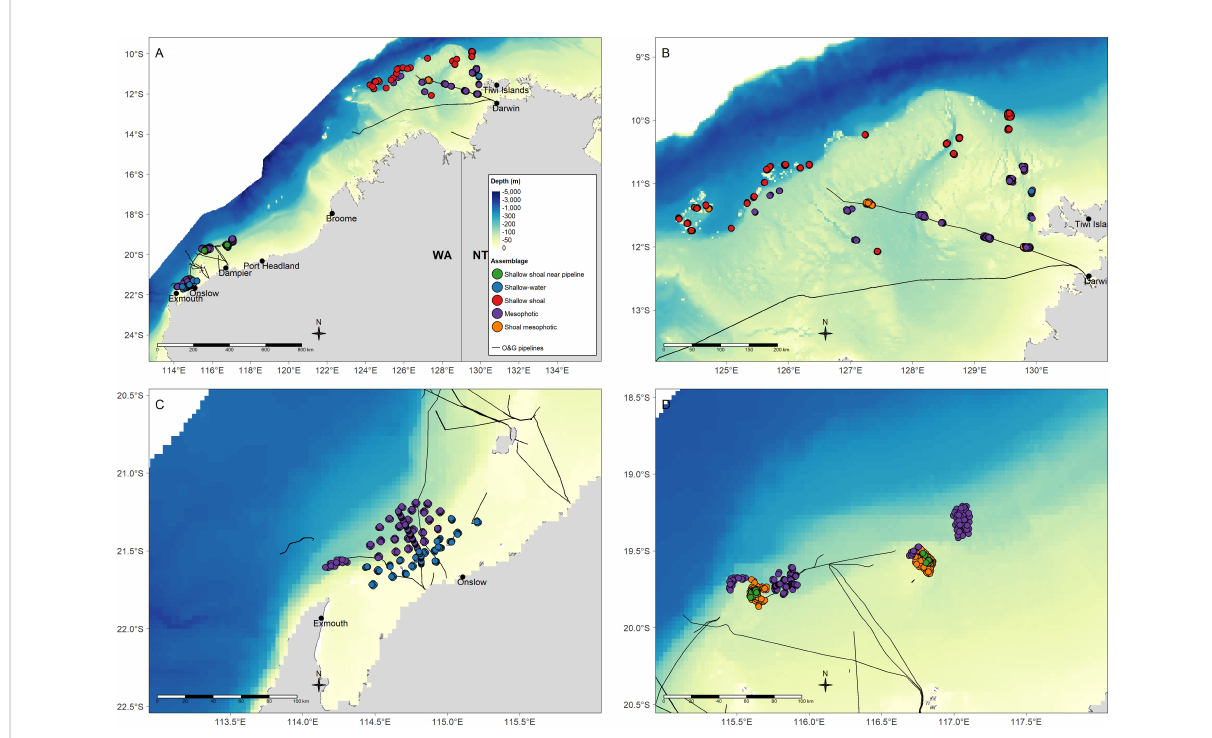
FIGURE 5 Spatial distribution of fi ve fi sh assemblages obtained from the MRT analysis of BRUVs data from three pipelines and historical AIMS surveys in NW Australia. (A) A regional setting of the NW Australia with the fi ve assemblages mapped. (B) The northern part of the study region west of Tiwi Islands and offshore from Darwin. (C) The southern part of the study region, southern Pilbara offshore from Onslow and north of Exmouth. (D) The southern part of the study region, mid-coast Pilbara and offshore from